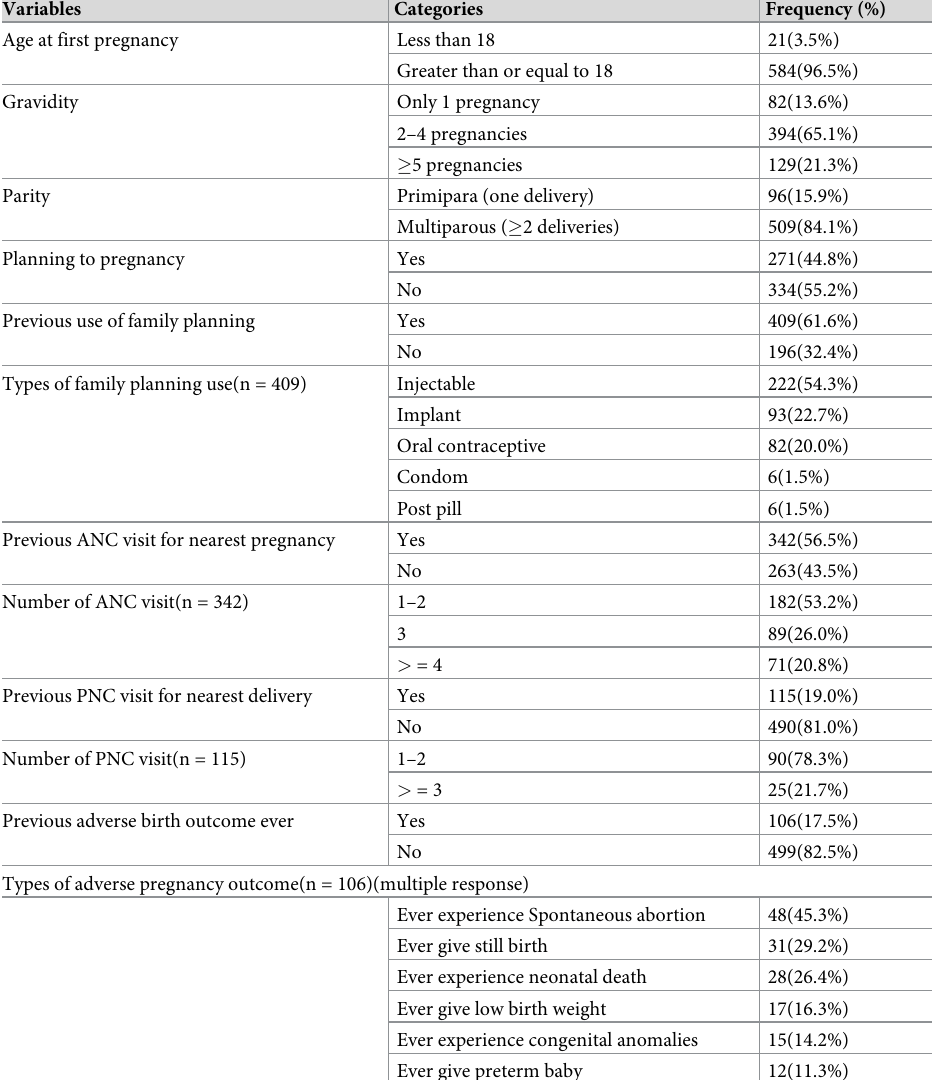
Table 2. Obstetric and reproductive health characteristics of reproductive age women in Mizan-Aman town, Bench-Sheko Zone, Southwest Ethiopia, 2020(n = 605).